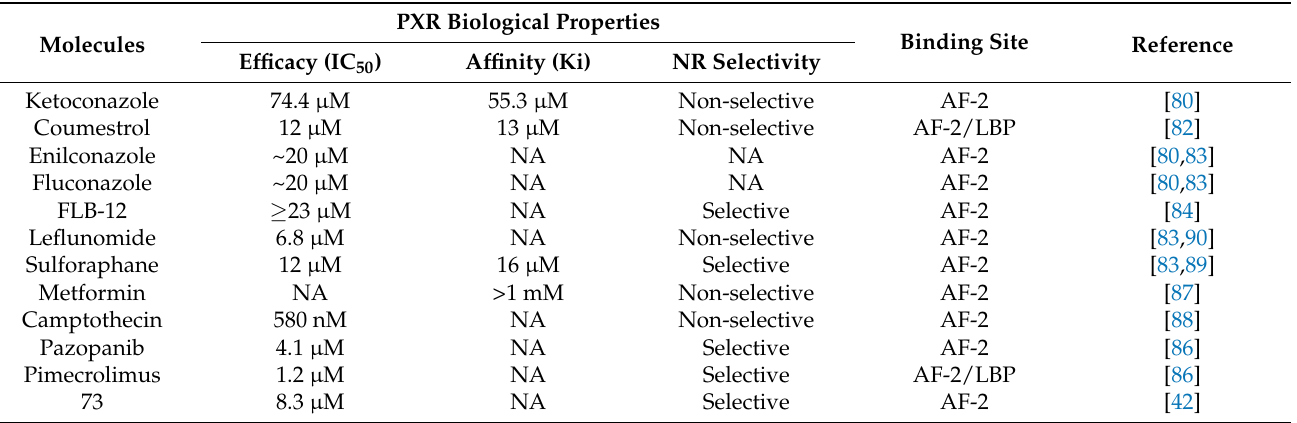
Figure 5. Chemical structures of known AF-2 site-binding PXR antagonists. RoA-routes of administration. The chemical structures were drawn in ChemDraw 20.0 software [80–84,86–89]. Table 1. A detailed list of antagonists that bind to the PXR AF-2 binding site.